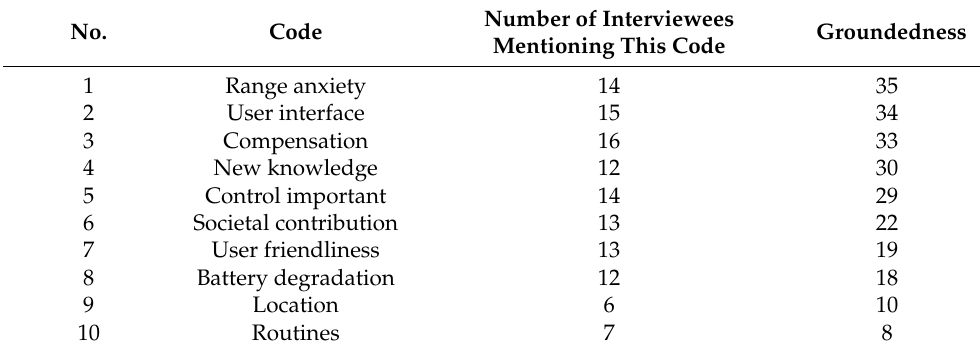
Table 1. Top ten codes mentioned by interviewees ordered by